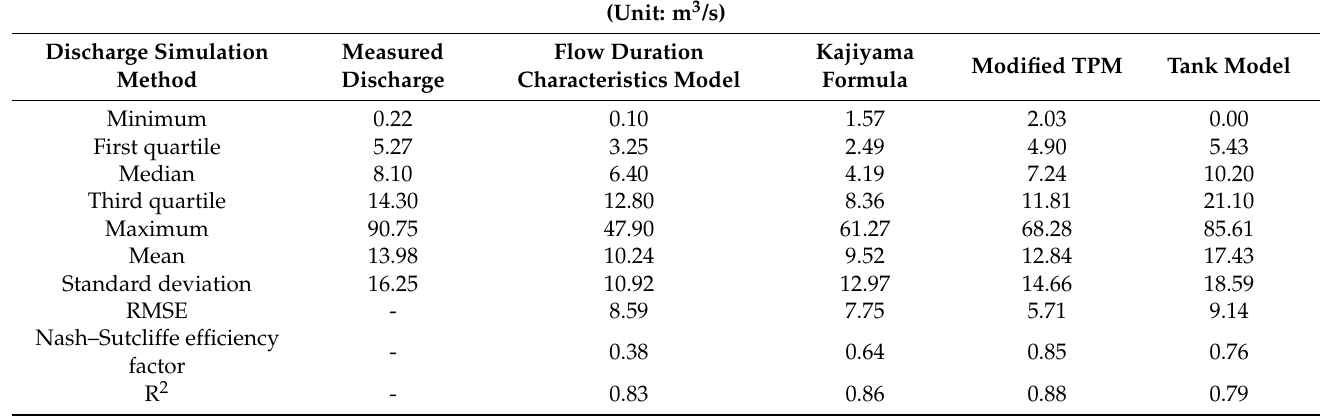
Table 8. Comparison of the distribution and statistics of the simulated and measured monthly average discharge for the Socheon SHP plant. (Unit: (cid:1813) (cid:2780) /(cid:1819))